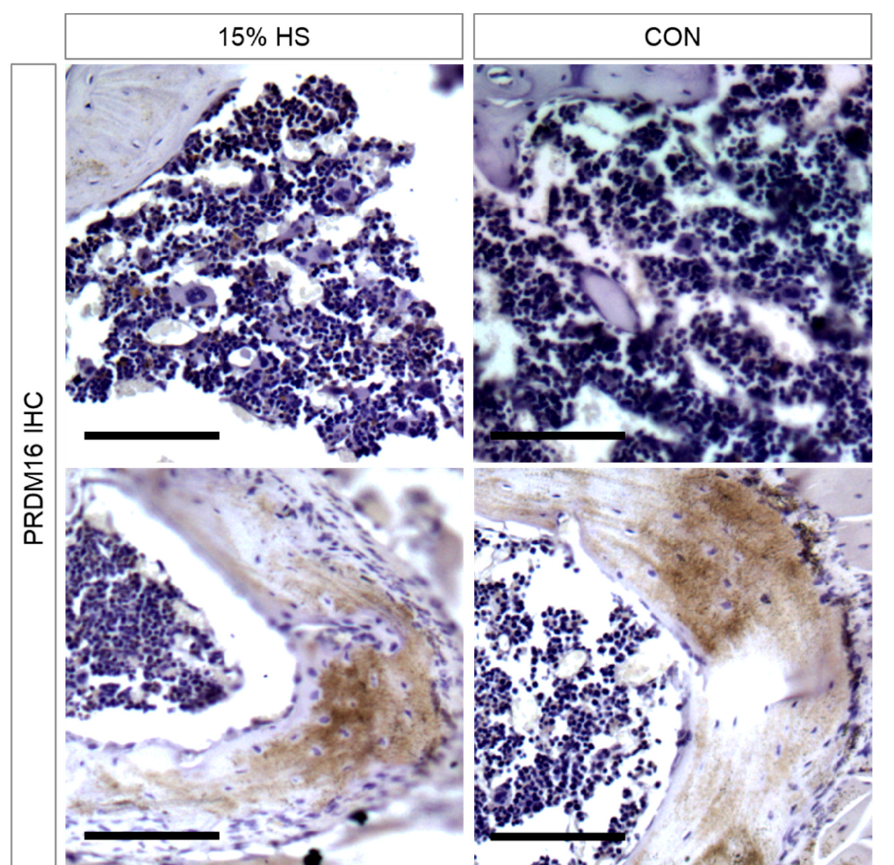
Figure 15. Humerus immunohistochemical staining of PRDM16-positive cells in representative mice from the 15% HS and control groups. Top row: Bone marrow sections showing the density of PRDM16-positive cells (brown color), an indication of differentiated adipocytes. Bottom row: Humerus metaphysis sections displaying comparable staining between the treatment groups. Scale bar indicates 100 µm.